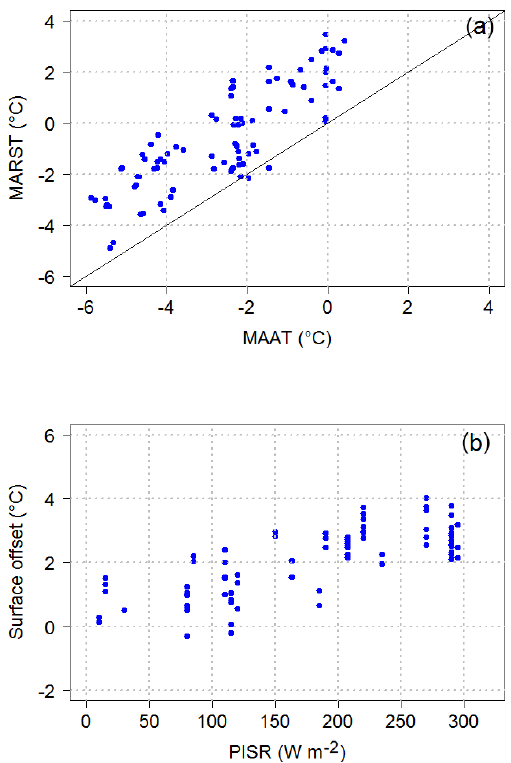
Figure 8. Relative distribution of steep rock walls across Norway (slopes > 40 ◦ based on the 10m resolution DEM). (a) Relative dis- tribution of rock wall surface area according to aspect and latitude. (b) Relative distribution of rock wall according to latitude, aspect and elevation. East: 45 to 135 ◦ ; south: 135 to 225 ◦ ; west: 225 to 315 ◦ ; north: 315 to 45 ◦ . The lowest and highest boundaries of the boxes respectively display the 1st and 3rd quartile ( Q 1 and Q 3) of the observations. The lowest and highest whiskers respectively show Q 1 − (( Q 3 − Q 1) × 1 . 5) and Q 3 + (( Q 3 − Q 1) × 1 . 5). The dots are the